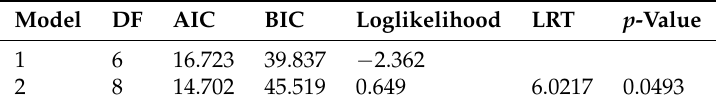
Table 4. Mixed effect model performance